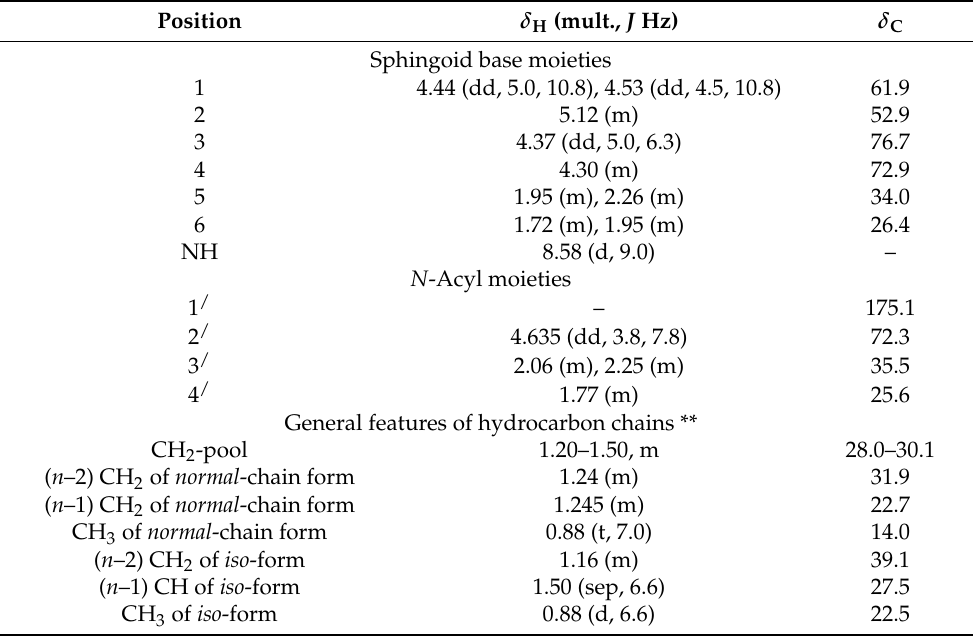
Table 1. 1 H- (700 MHz) and 13 C- (125 MHz) NMR data * for the total ceramide of M. clathrata (C 5 D 5